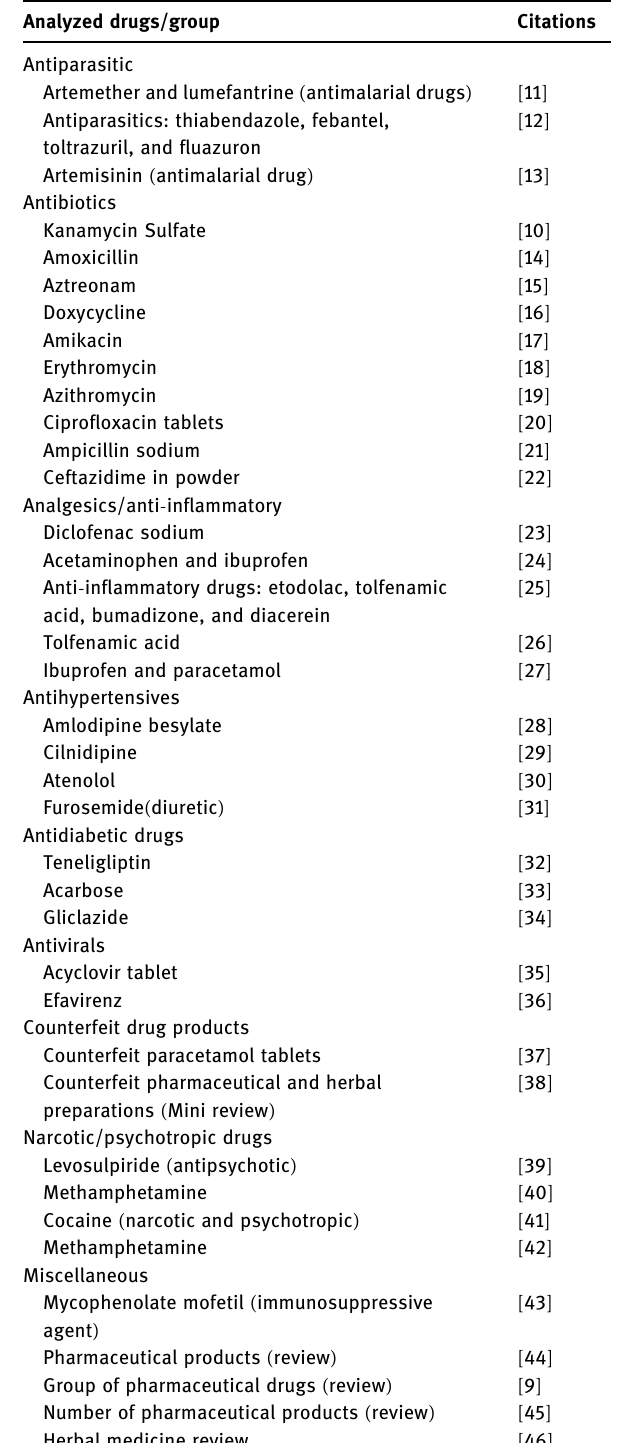
Table 2: List of selected drugs and pharmaceutical dosage forms analyzed using FTIR spectroscopy Analyzed